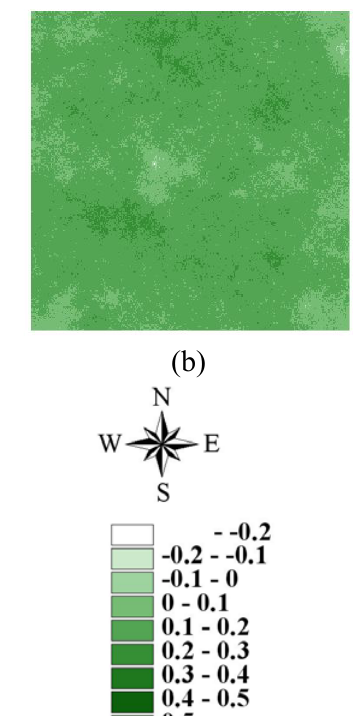
Figure 12. Conditional simulated NDVI images for area A based on (a) 100, (b) 500, and (c) 1,000 cLHS samples on 1999/10/31